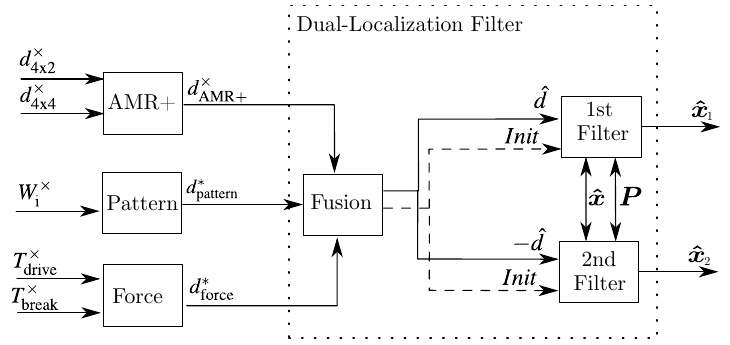
Figure 1. Rolling direction estimation and Dual-Localization filter